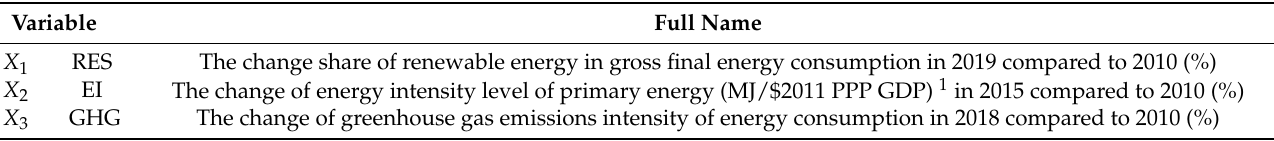
Table 3. Variable